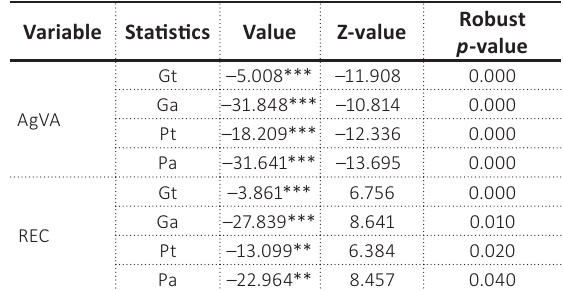
Table 5. Westerlund ECM panel